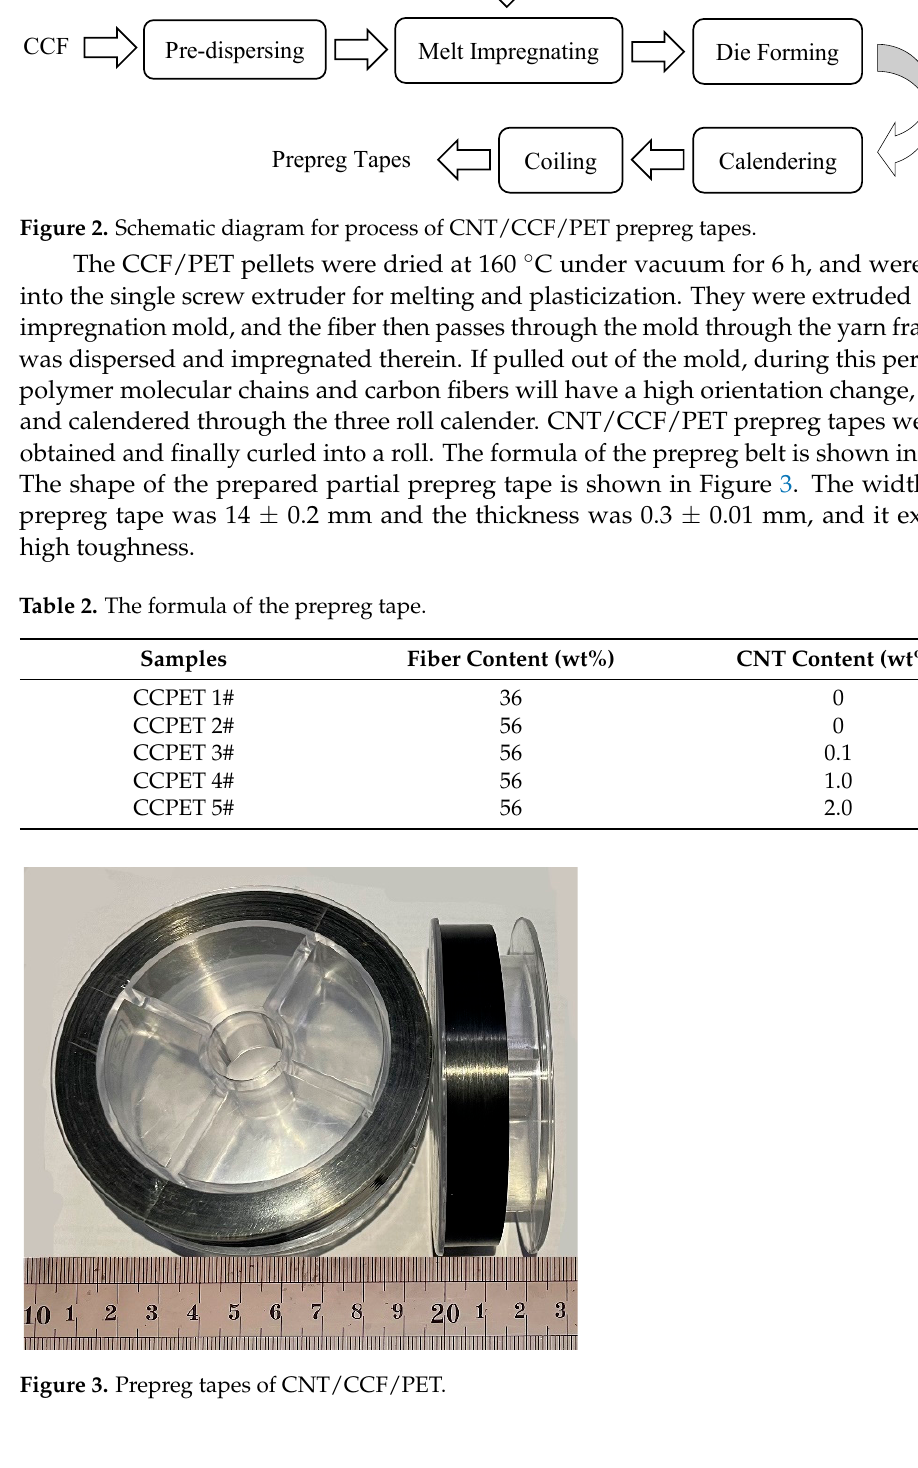
4 of 21 Figure 1. Schematic diagram for the process of CNT/PET pellets. 2.2.2. Preparation of Prepreg Tape The CNT/CCF/PET prepreg tapes were prepared by a special continuous fiber reinforced thermoplastic composite melting laboratory impregnation device; it was designed and assembled by the authors. The preparation process diagram is shown in Figure 2. Yarn frame (ADC–2) was produced by Guangzhou Aosai Carbon Fiber Technology Co., Ltd., Guangdong, China. The single screw extruder with a screw diameter of 20 mm and three-roll calendar (CL–T110) were produced by Harbin Hapu Electric Technology Co., Ltd., Harbin, China. The CCF/PET pellets were dried at 160 °C under vacuum for 6 h, and were added into the single screw extruder for melting and plasticization. They were extruded into the